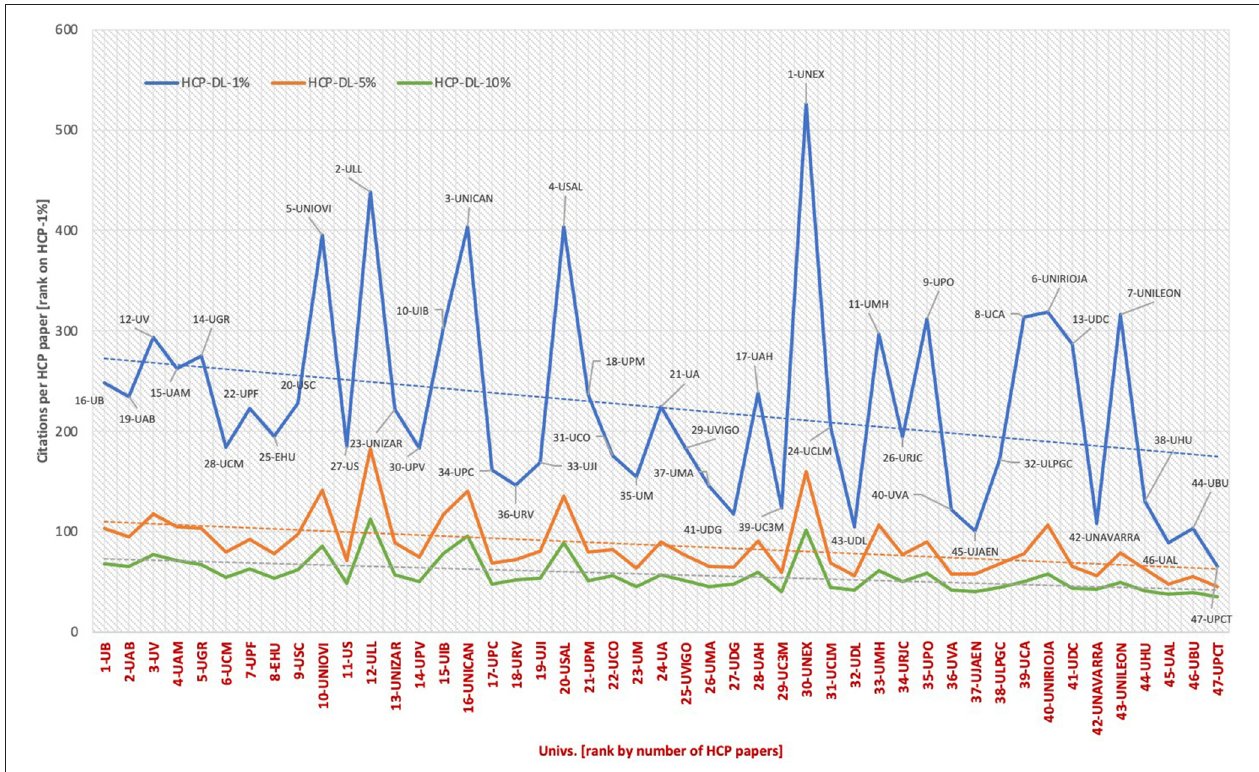
FIGURE 5 | HCP-DL percentage at Spanish public universities (1, 5, and